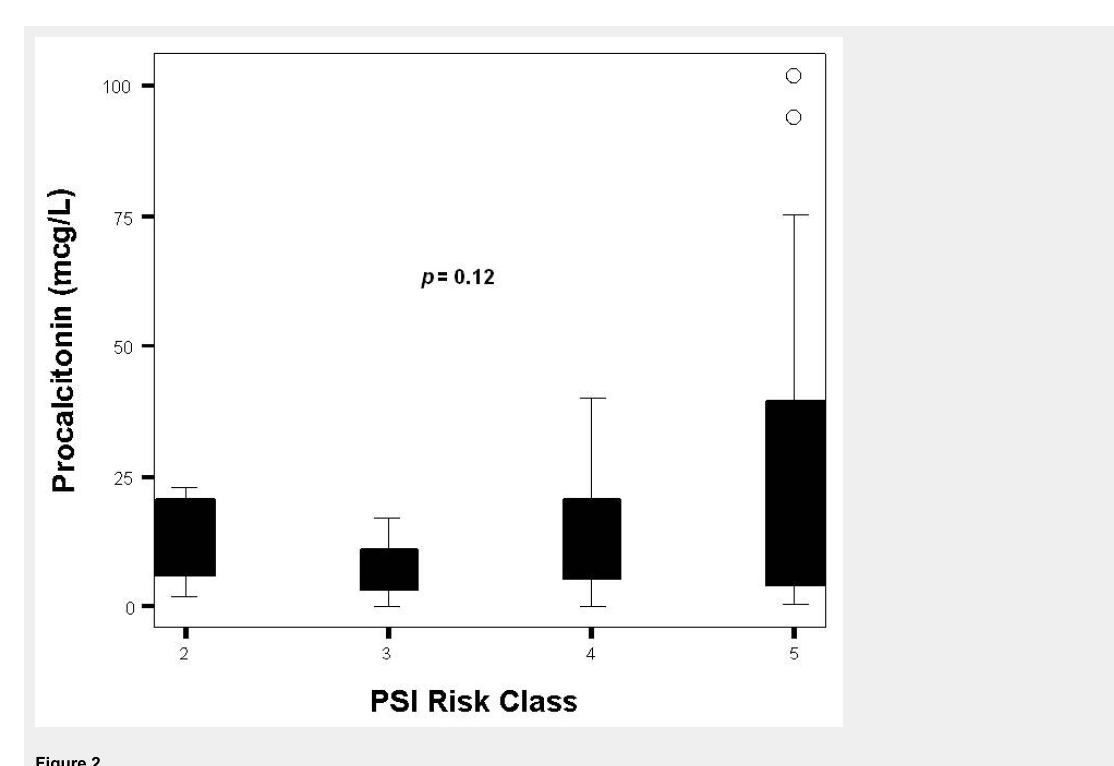
Figure 2 Distribution of PCT levels by PSI